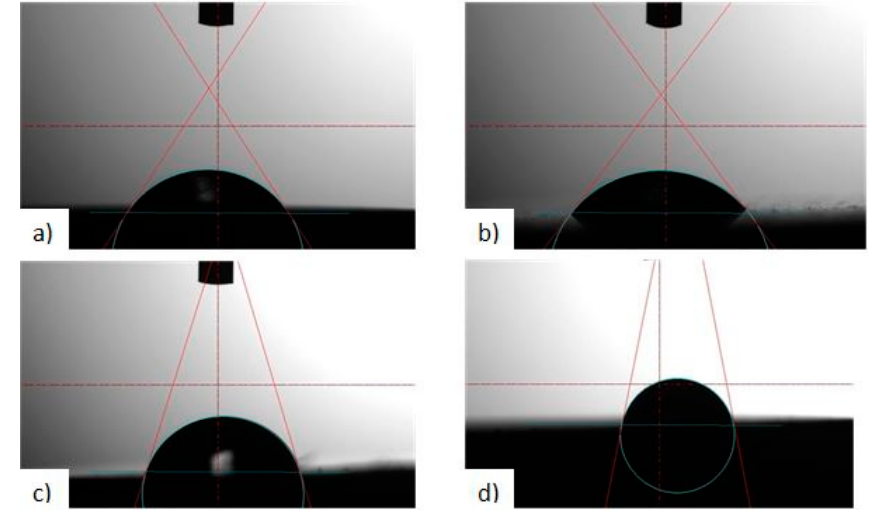
Figure 5. Example contact angle measurement for a sample: ( a ) polished, initial state, ( b ) sand-blasted, initial state, ( c ) polished, with the DLC coating, ( d ) sand-blasted with the DLC coating.